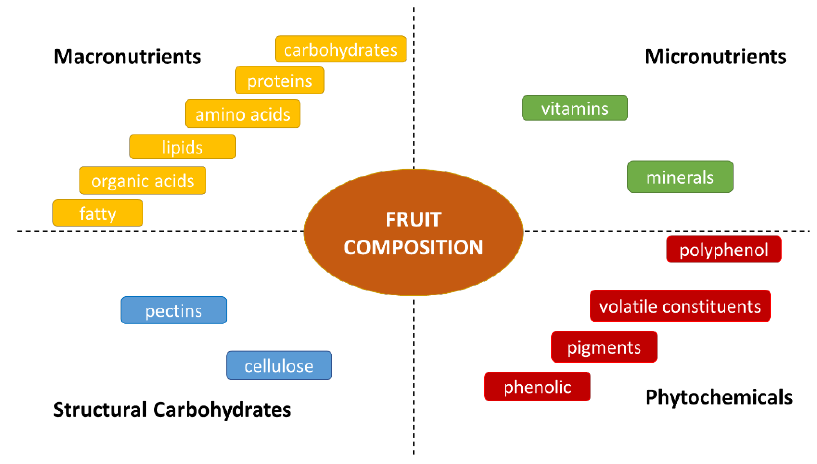
Figure 1. Fruit composition.